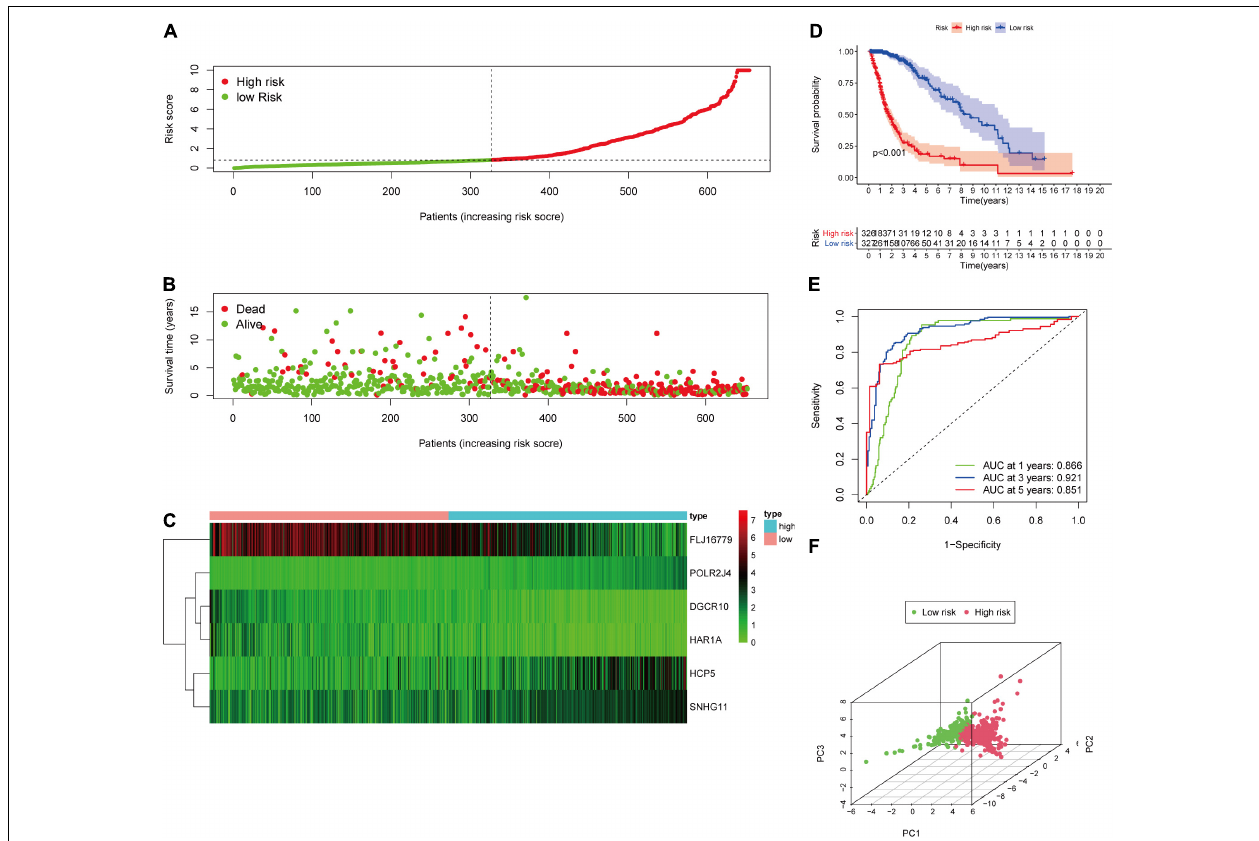
FIGURE 4 | Validation of the immune-related lncRNA prognostic risk score model. (A) The distribution of risk score. (B) The distribution of patients’ survival time and status. (C) Heatmap of selected six immune-related lncRNAs of the classifier. (D) Kaplan–Meier curves of high-risk and low-risk score groups. (E) Time-dependent ROC analyses of the identified immune-related risk signature. (F) PCA analysis based on six survival-related immune lncRNAs.